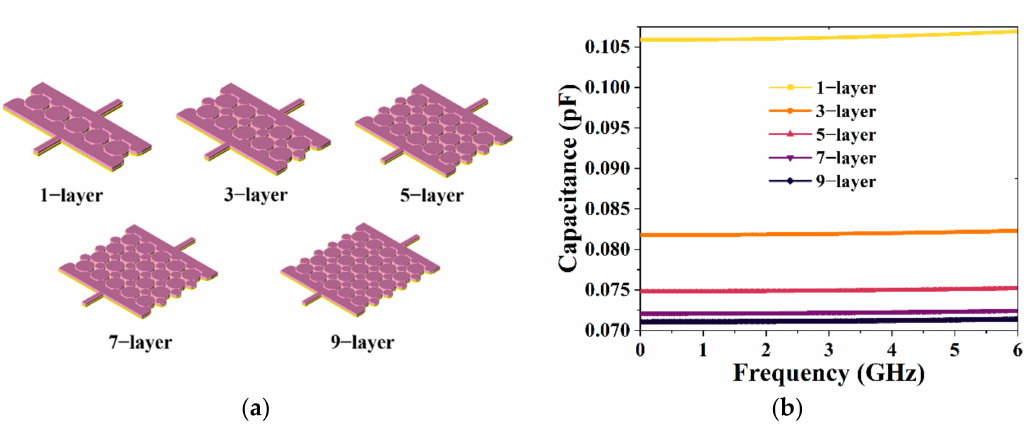
Figure 4. ( a ) Three-dimensional structure of the proposed capacitor with 1-layer, 3-layer, 5-layer, 7-layer, and 9-layer GSMS, as well as their corresponding ( b ) capacitance